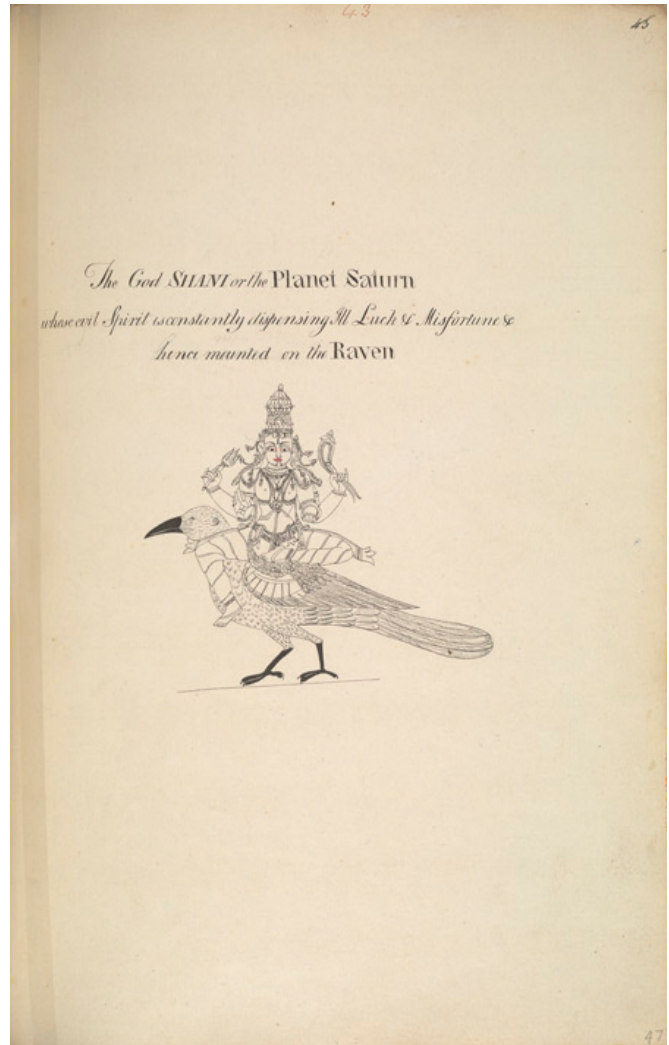
Figure 1. Pen and ink sketch of Shani from Minakshi Sundareshvara Temple, Madurai, from ‘Album of 51 drawings (57 folios) of buildings, sculpture, and paintings in the temple and choultry of Tirumala Nayyak at Madura.’ Date: c. 1801-05. Artist: Anonymous. Source: British Library.